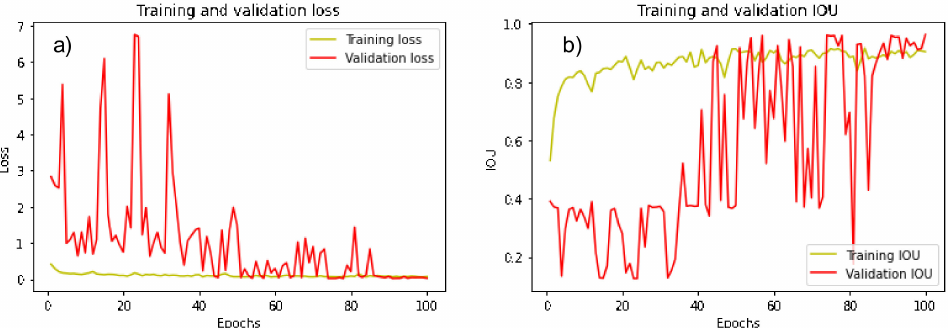
Figure 14. Training and validation ( a ) loss and ( b )